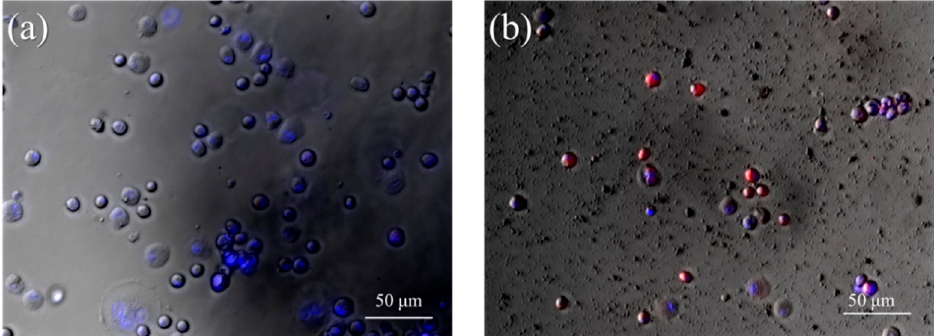
Figure 6. Overlaid image (fluorescence and bright) of WEHI 274.1 monocytes cultured with ( a ) Cy5- MNPs or ( b ) Cy5-MCP-1-motif